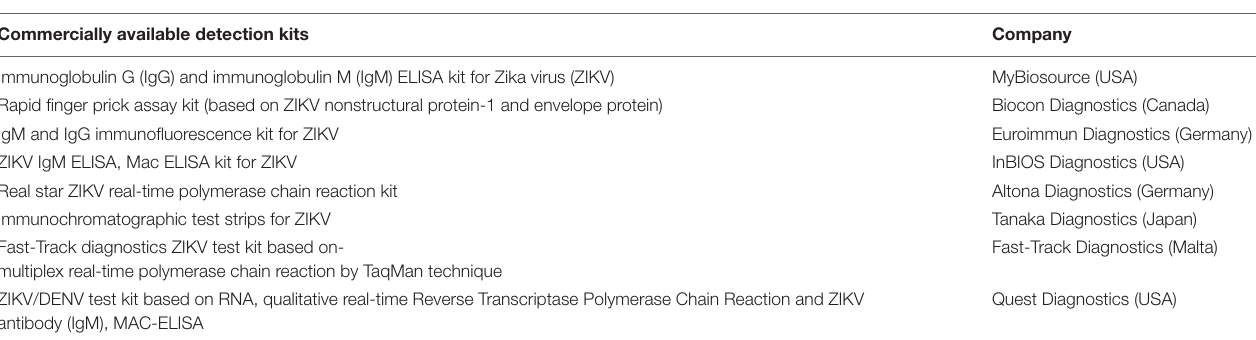
TABLE 2 | Update on commercially available detection kits for Zika virus. Commercially available detection